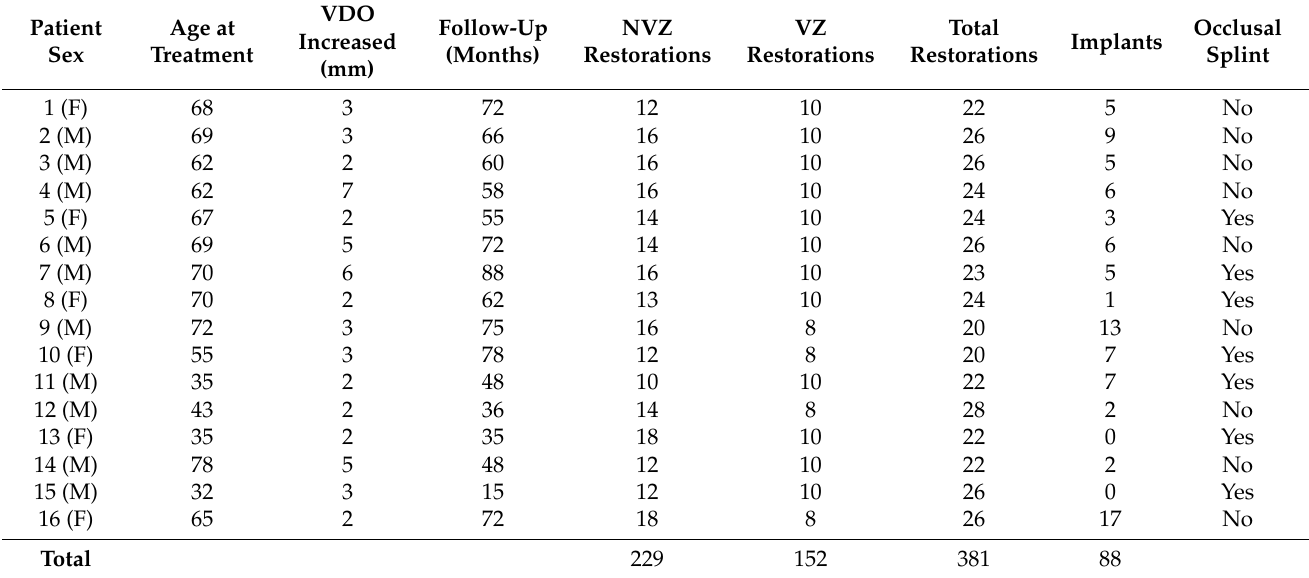
Table 1. Patient variables, restorations, materials and